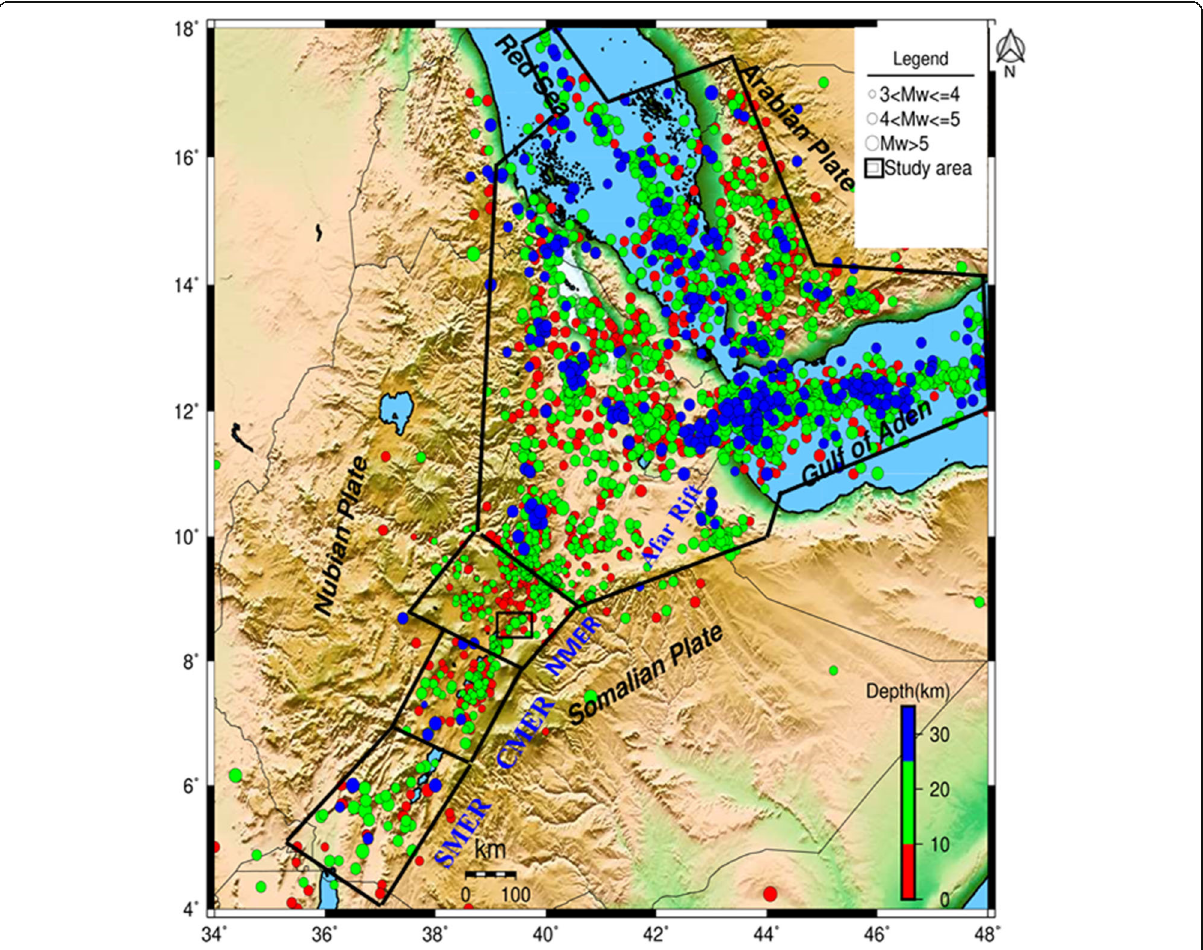
Fig. 2 Seismicity Map of Ethiopian Rifts (Including Red Sea and Gulf of Aden rifts) from the new catalog. The legend color bar on the right bottom of the map indicates the Hypocenteral depths variations of Earthquake. The rectangular legend on the top right of the map indicates the size of the of the Earthquakes magnitude ’ s ranges in Moment magnitude scale in the